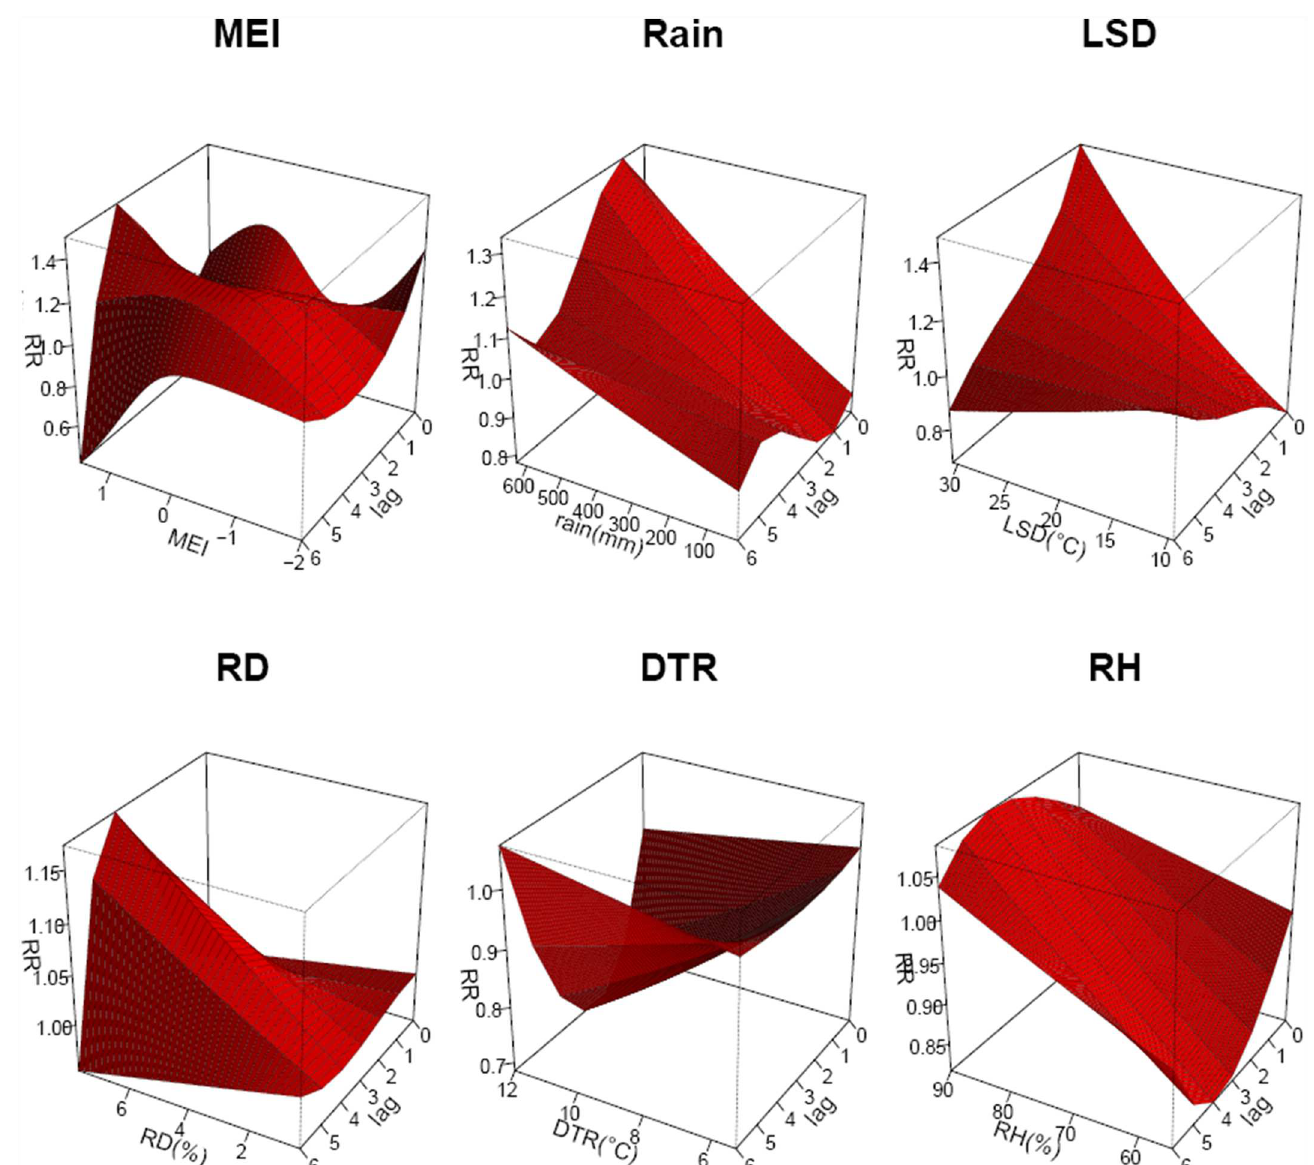
Fig 5. The three dimensional relationships of land surfacetemperature, relative humidity, rainfall, and diurnal temperature range (x-axis), lag (z-axis) and relative risk of scrub typhus incidence (y-axis).